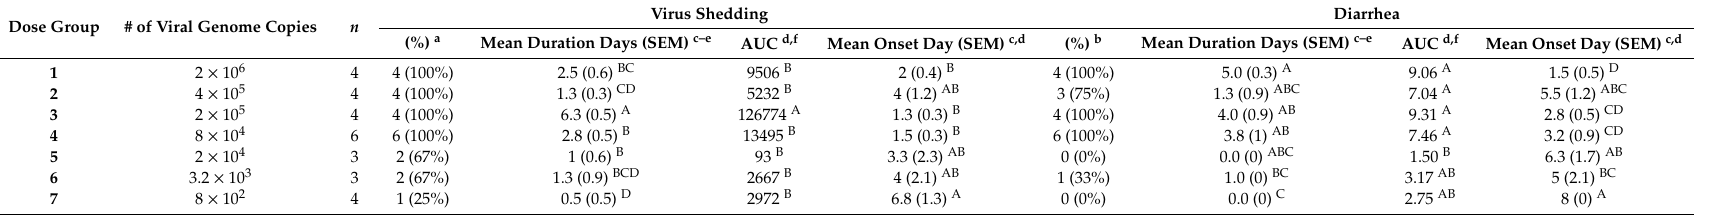
Table 1. HuNoV fecal shedding and diarrhea after inoculation of Gn pigs with di ff erent doses of Cin-2. Virus Shedding Diarrhea Dose Group # of Viral Genome Copies n Mean Duration Days (SEM) c–e AUC